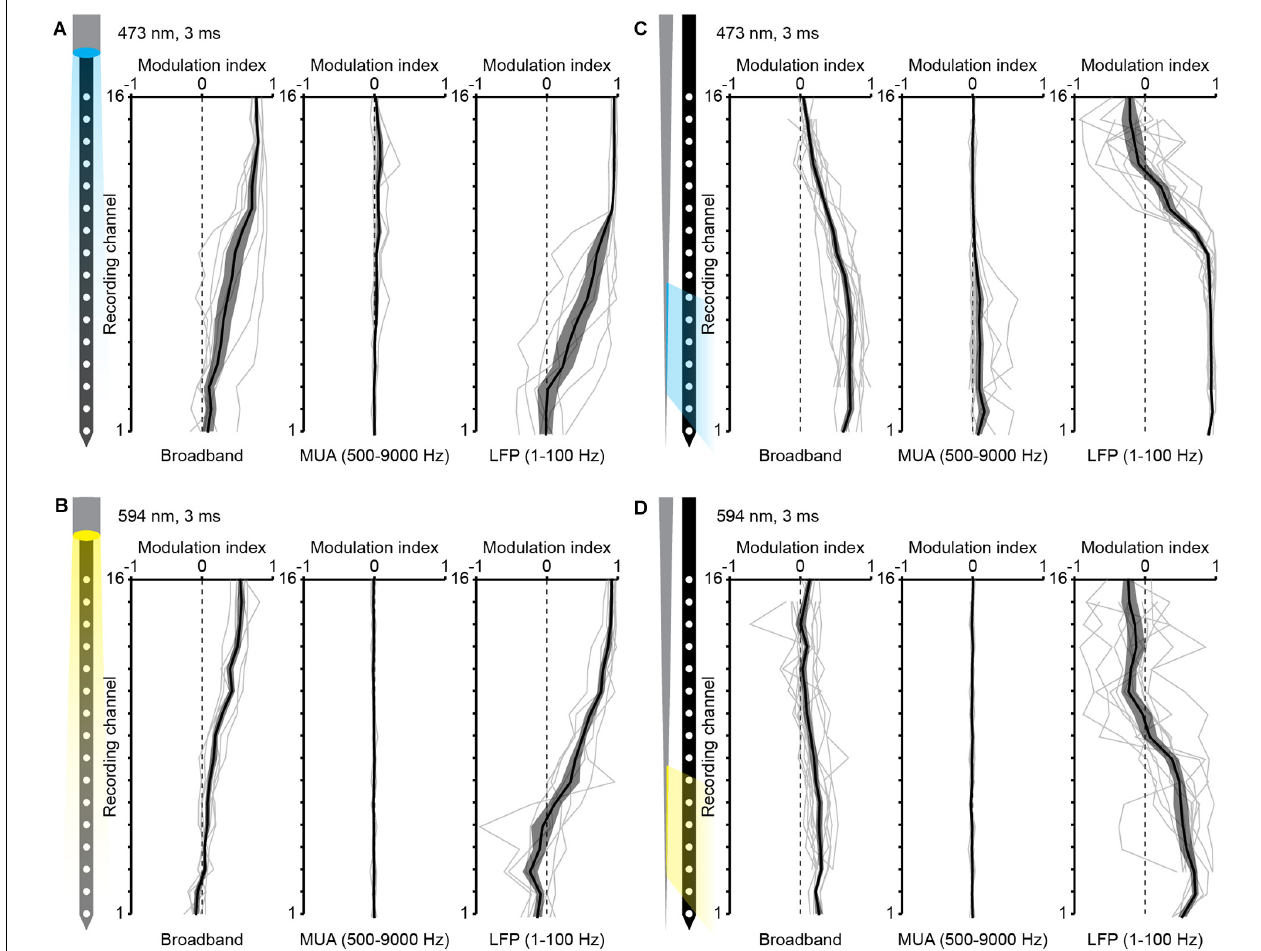
FIGURE 4 | In vivo experiments over multiple animals. (A) Quantification of the modulation index over recording sites for illumination with blue light pulses (3 ms, 473 nm) with a commercial optrode with illumination from the top ( n = 7 mice). (B) Same as A for illumination from the side with a TF ( n = 12 mice). (C) Same as A with yellow light (3 ms, 596 nm) to estimate photoelectric response. (D) Same as C to estimate photoelectric response of TF-based optrodes.